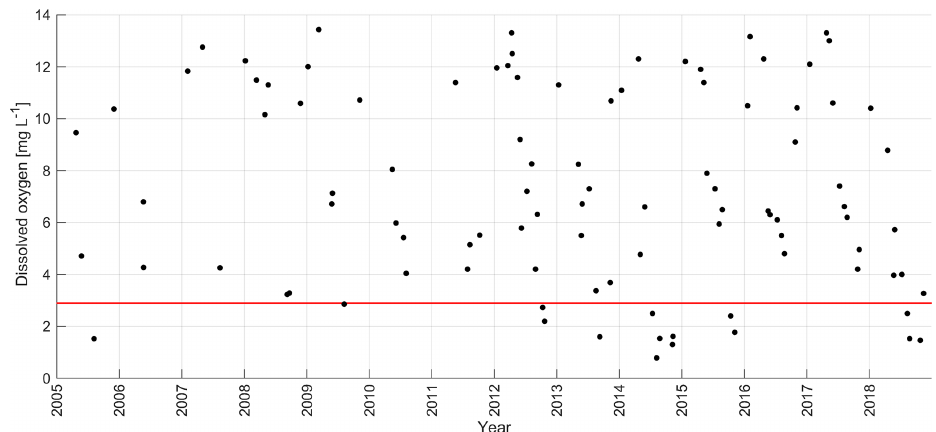
Figure 2. Inter-annual variability of near-bottom dissolved oxygen concentration at monitoring stations G1 and 121 in 2005–2018. The red line denotes the oxygen concentration 2.9mgL − 1 (threshold concentration for